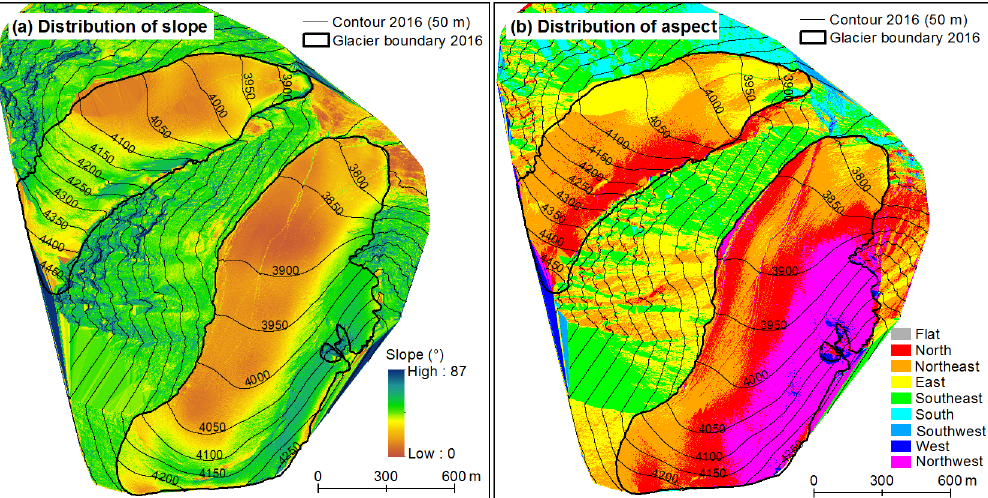
Figure 11. Spatially distributed slope (a) and aspect (b) of Urumqi Glacier No. 1 extracted from the TLS-derived DEM on 1 September